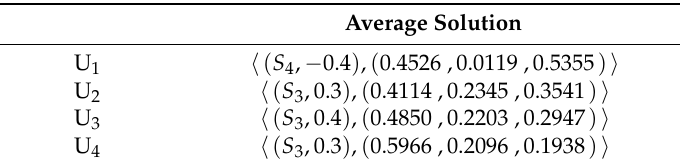
Table 5. The value of the average solution (AV).